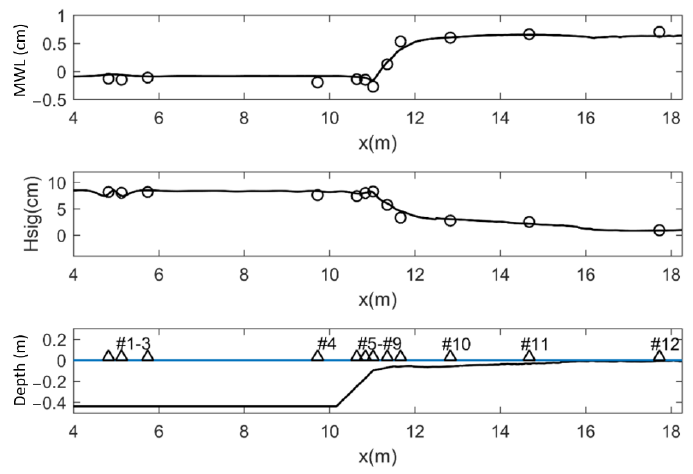
Figure 8. Variation of the significant wave height and mean water level over the reef profile for Case 182. Solid line: predictions by present model; open circles: laboratory measurements.